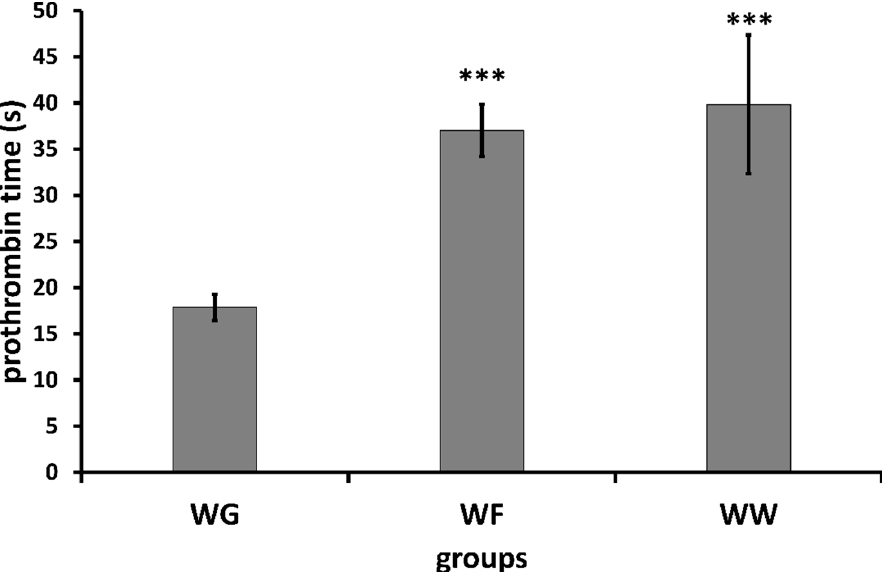
Figure 1. Mean ± SD of prothrombin time determined by means of mechanical coagulometer (WG: wheatgrass; WF: warfarin; WW: wheatgrass + warfarin). *** p < 0.01.